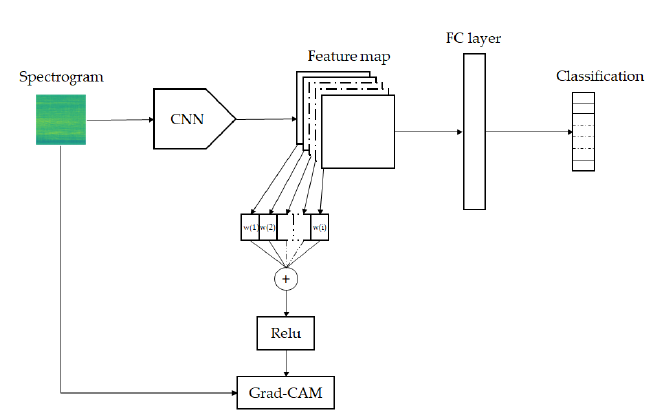
Figure 17. Grad-CAM flow chart